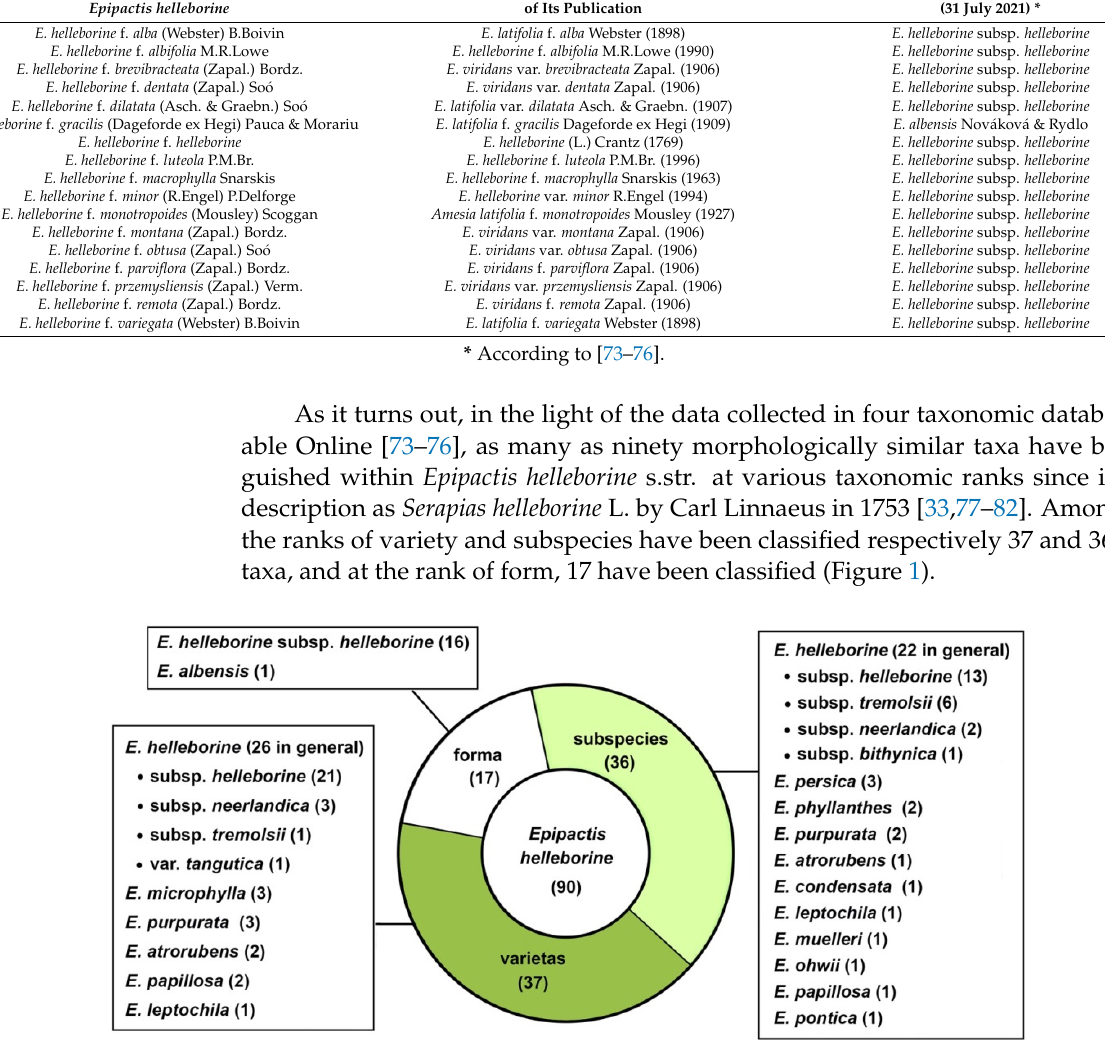
Figure 1. The current status of names of infraspecific taxa published in Epipactis helleborine categorised according to their taxonomic ranks, based on [73–76]. The number of names synonymised with E. helleborine s.l. and with other species is shown in parentheses.